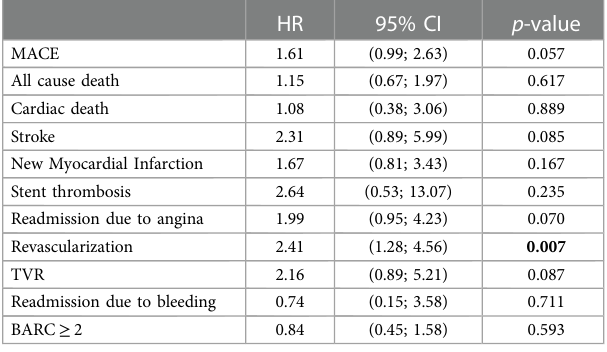
TABLE 3 Cox proportional hazard model for clinical events between groups.